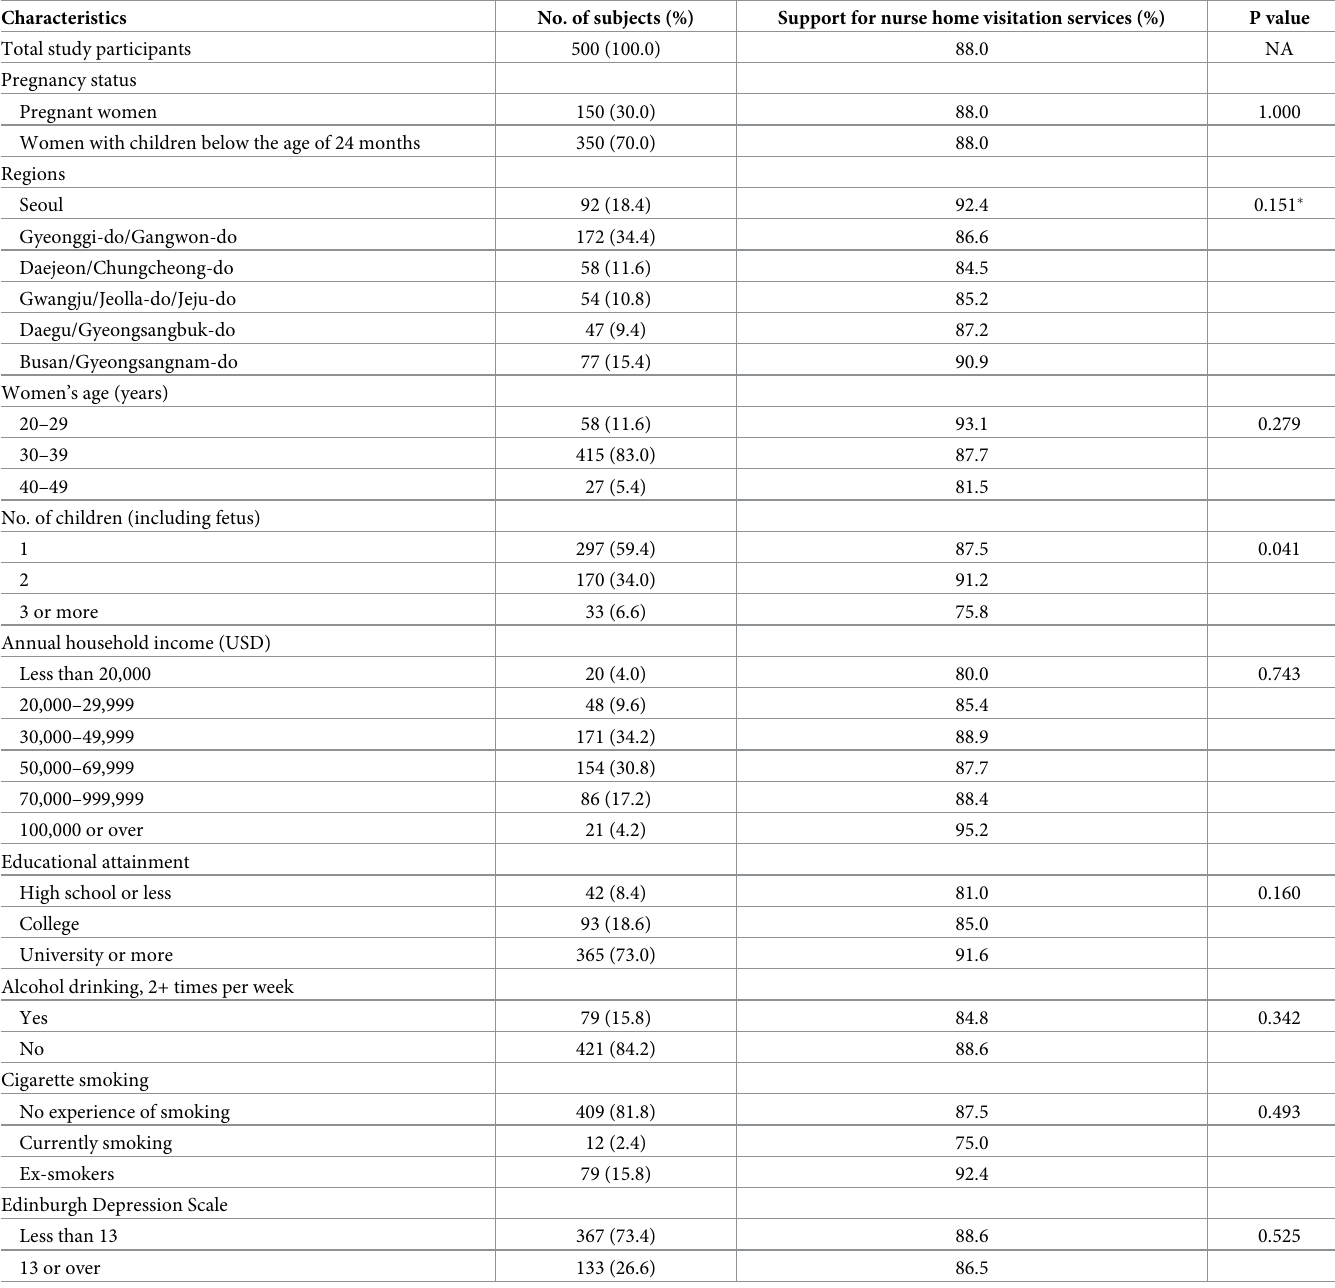
Table 2. Support for nurse home visitation services (%) among pregnant women and mothers with children below the age of 24 months (N = 500).